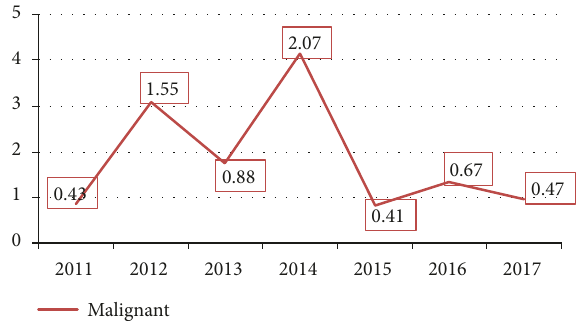
Figure 4: Incidence rates of malignant cases in 100,000 populations over seven